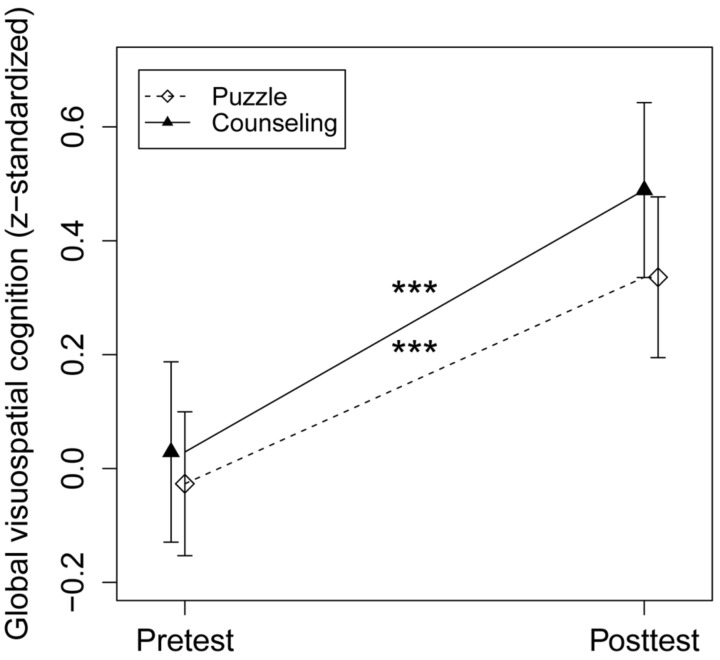
Intervention effect on the primary outcome. The puzzle group showed a pretest–posttest improvement of d = 0.38, p < 0.001; the counseling group of d = 0.46, p < 0.001, with an intervention effect size in favor of the counseling group of d = 0.08, p = 0.39; ∗∗∗p < 0.001.